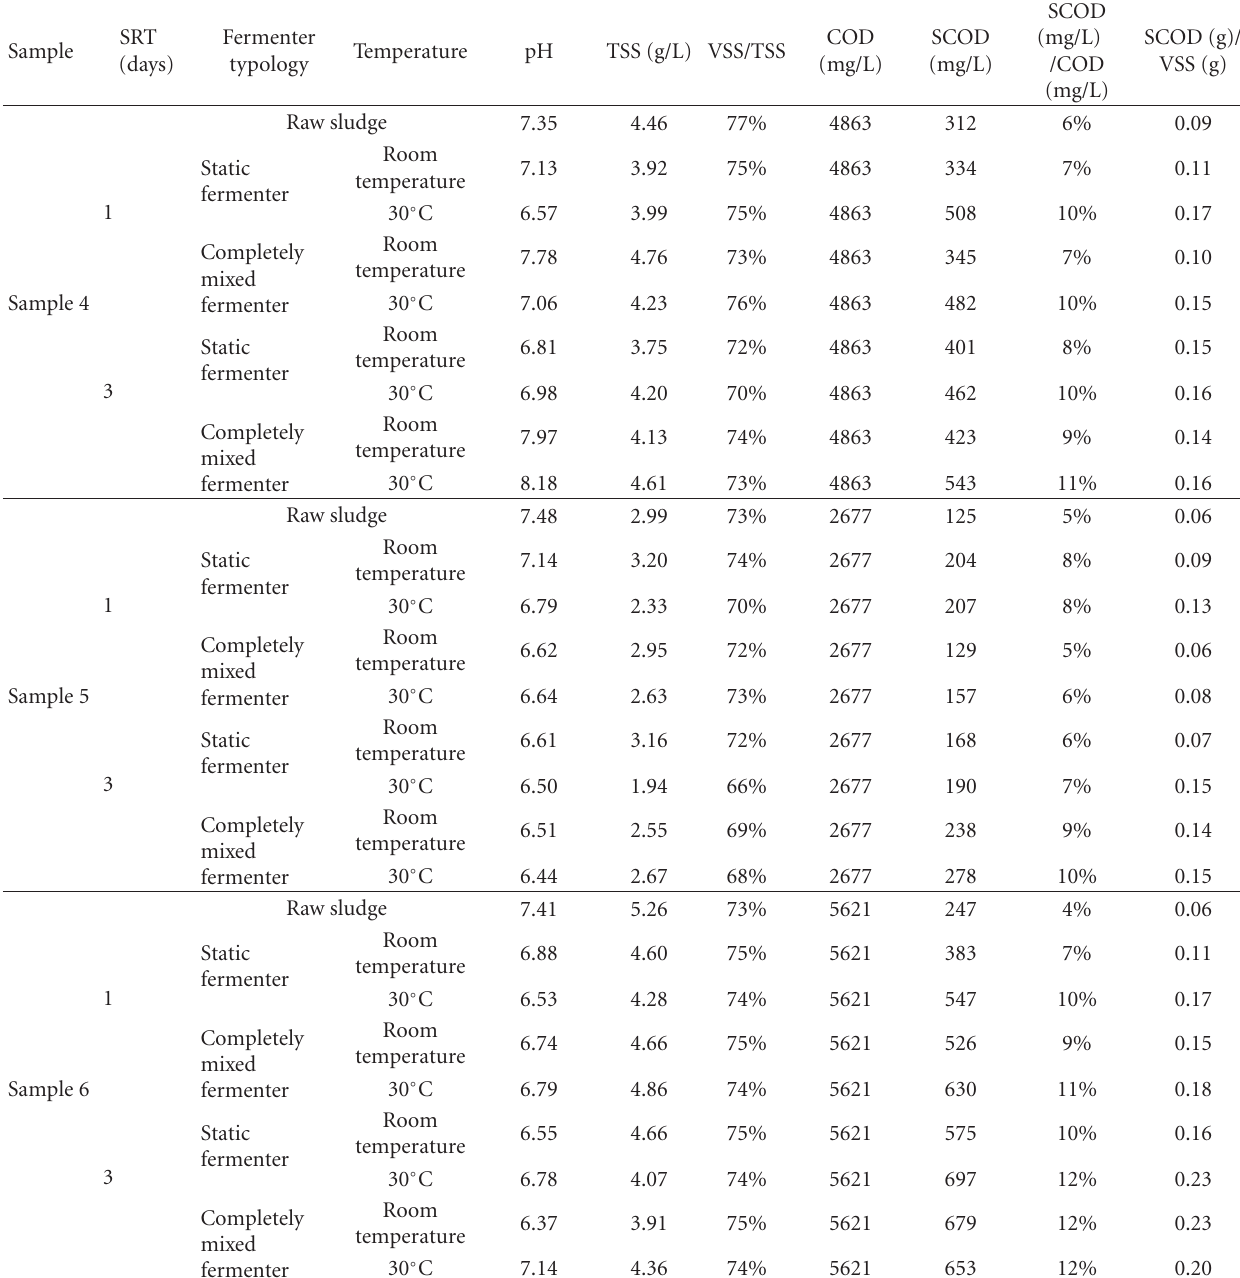
Table 3: Influence of temperature, agitation, sludge concentration, and SRT on PS from WWTP 2 fermentation: SCOD yield and specific SCOD